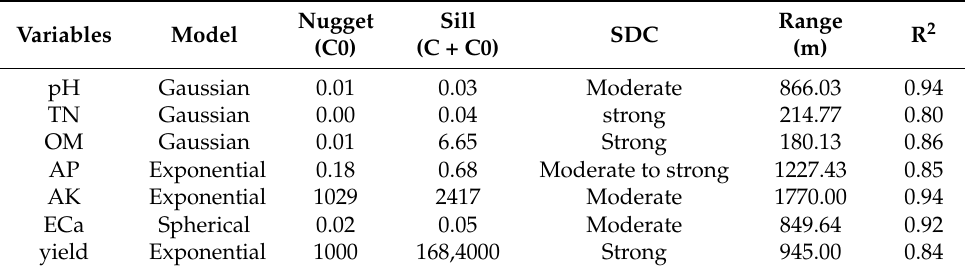
Table 2. Semivariogram models and related geostatistical parameters for characterizing the spatial dependence of soil variables.